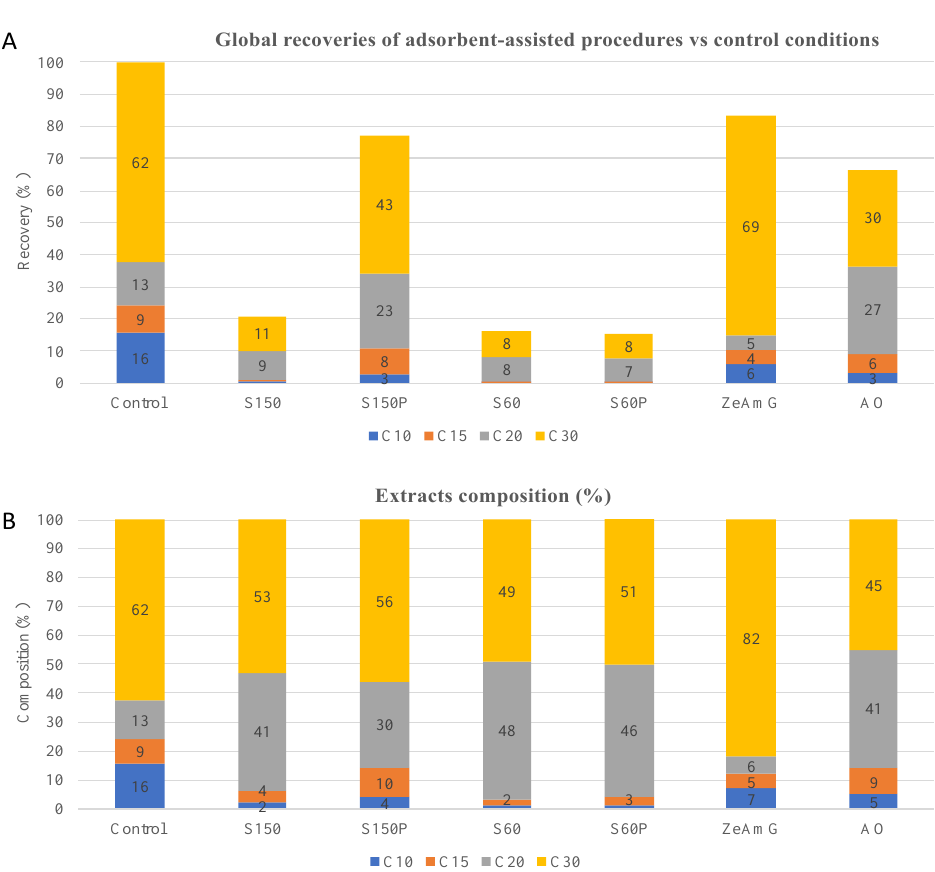
Figure 4. Global terpenoid families’ recoveries ( A ) and terpenoid families’ composition ( B ) of olive leaves extracts obtained by the studied adsorbent-assisted processes and under control conditions (no